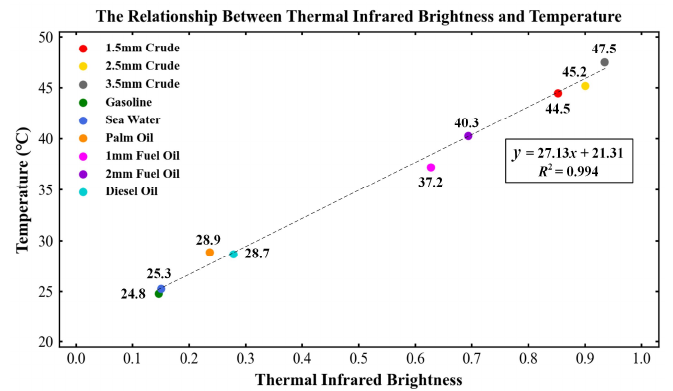
Figure 20. Relationship between thermal infrared brightness and oil spill temperature.